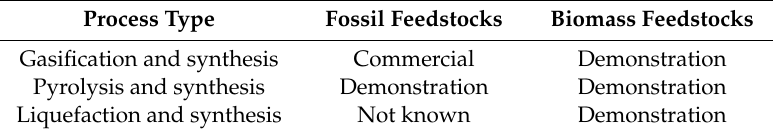
Table 6. Technical readiness of advanced chemical processes.